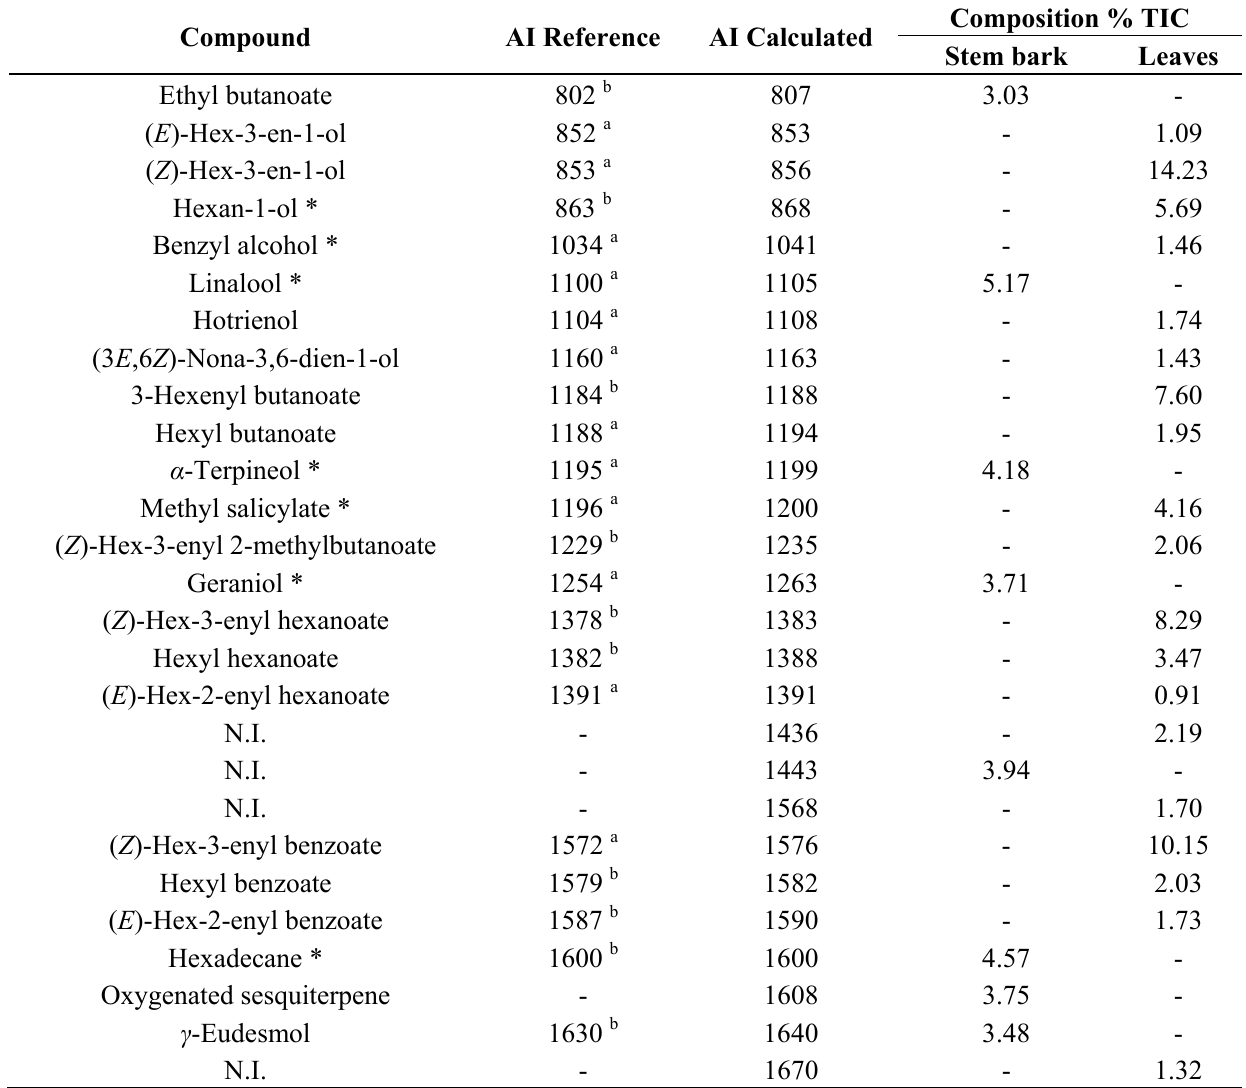
Table 1. Chemical composition of the essential oil from the stem bark and leaves of I. laurina in the dry